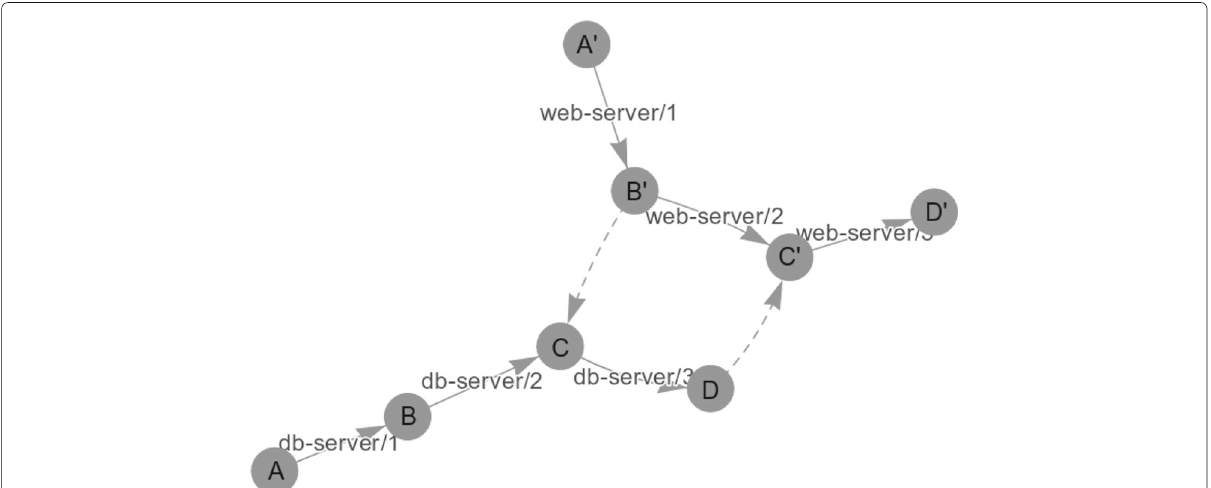
Fig. 5 Wordpress deployment graph with 1 Web Server and 1 Database